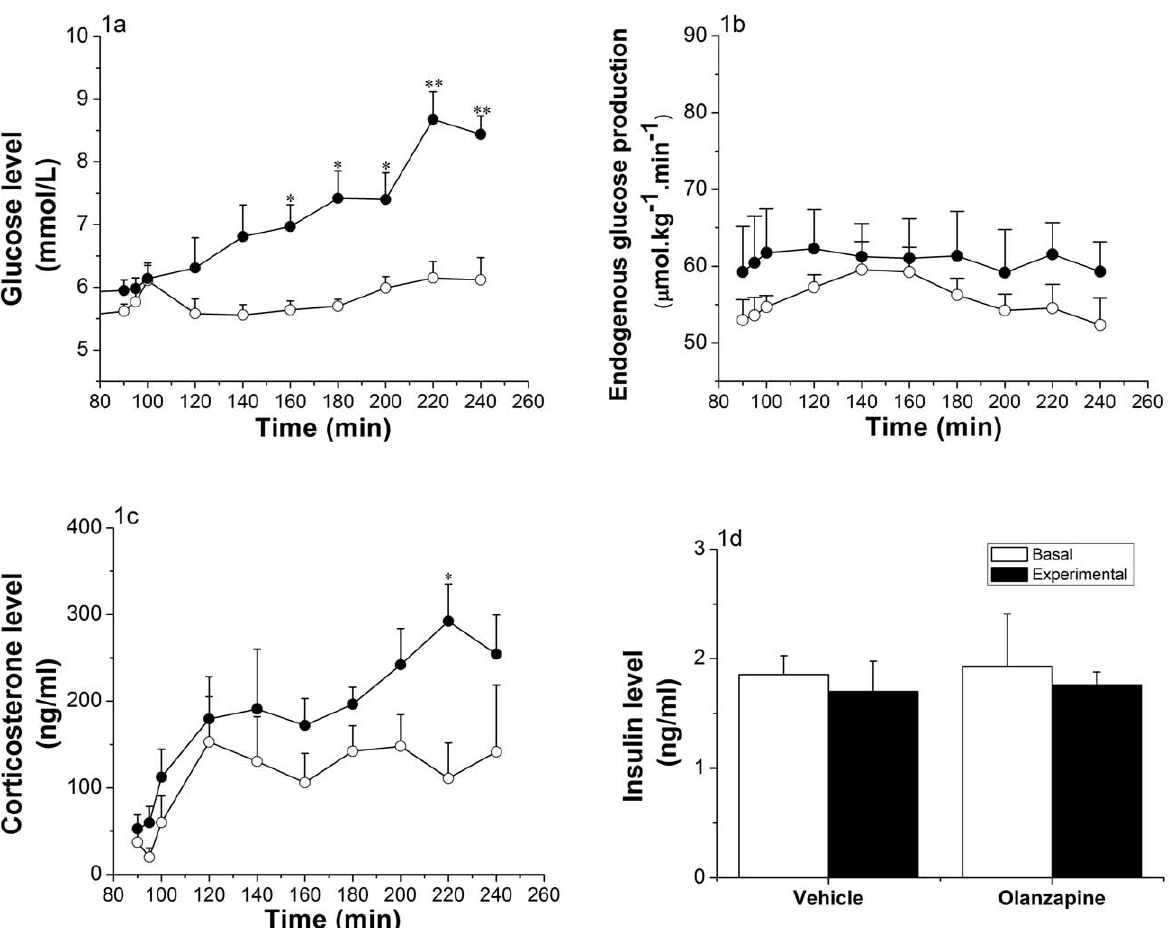
Figure 1. Effects of intragastric infusion of Olanzapine. (Vehicle group n=5, Olanzapine group n=6). 1a: Glucose evolution before (t=90 to t=100) and during (t=120 to t=240) the intragastric infusion of Olanzapine infusion (3 mg/kg/h). Glycemia significantly increased after 60 min of Olanzapine infusion (*p , 0.05, **p , 0.001; ANOVA repeated measures; Time, p , 0.001; Time * Group, p , 0.001; Group, p=0.001). 1b: Endogenous glucose production before (t=90 to t=100) and during (t=120 to t=240) intragastric Olanzapine infusion. No significant changes were observed (ANOVA repeated measures; Time, p=0.426; Time * Group, p=0.937; Group, p=0.356). 1c: Corticosterone levels before (t=90 to t=100) and during (t=120 to t=240) intragastric Olanzapine infusion. Corticosterone levels are significantly higher in the Olanzapine group only at t=220 (*p , 0.05; ANOVA repeated measures; Time, p , 0.001; Time * Group, p=0.58; Group, p=0.039). 1d: Plasma insulin levels before (mean of time points t=90 and t=100) and at the end (mean of time points t=180 and t=220) of the intragastric infusion of Olanzapine. No significant differences were detected (ANOVA repeated measures; Time, p=0.601; Time * Group, p=0.981; Group, p=0.834). Vehicle-treated animals = white dots; Olanzapine-treated animals = black